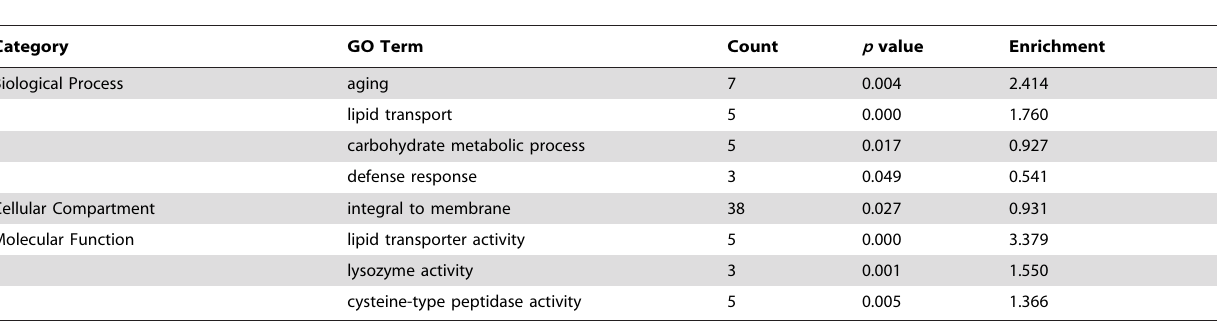
Table 3. Functional classification of genes down-regulated in wdr-23